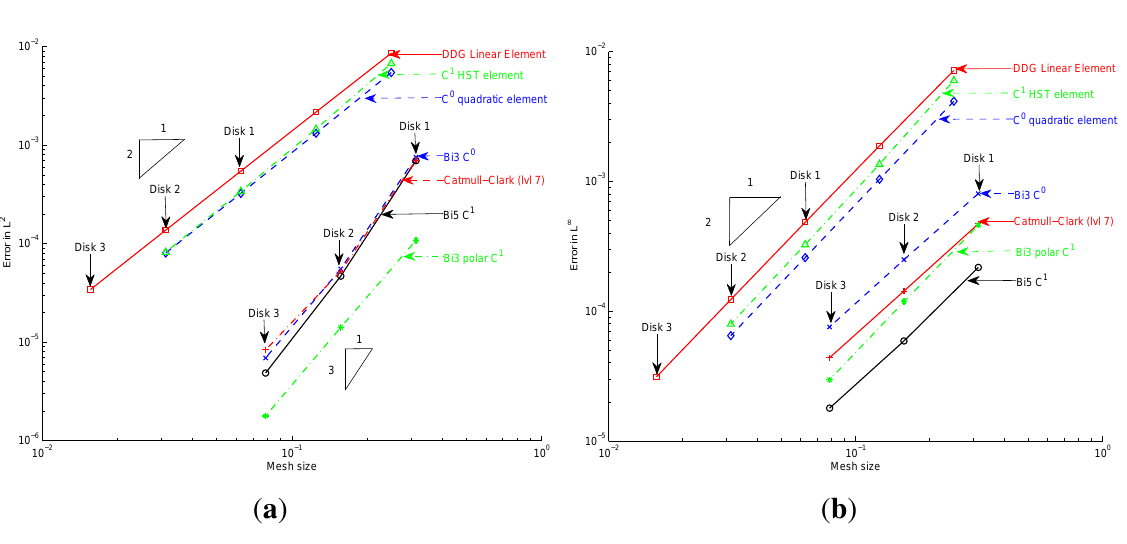
Figure 10. Convergence comparison between methods. Note that the graphs are in log -scale (the triangle indicates the convergence exponent in log -scale) and that higher mesh density is to the left, as the mesh spacing on the abscissa decreases. ( a ) Error in L 2 ; ( b ) error in L ∞ .